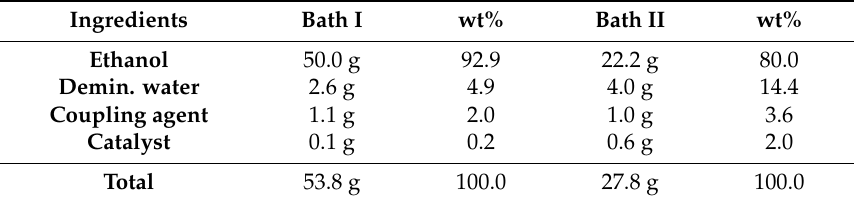
Table 3. Dipping recipes used for rayon and PET cords with TEOS coating (TESPT as well as MPTES used for Bath I; TESPT for Bath II).